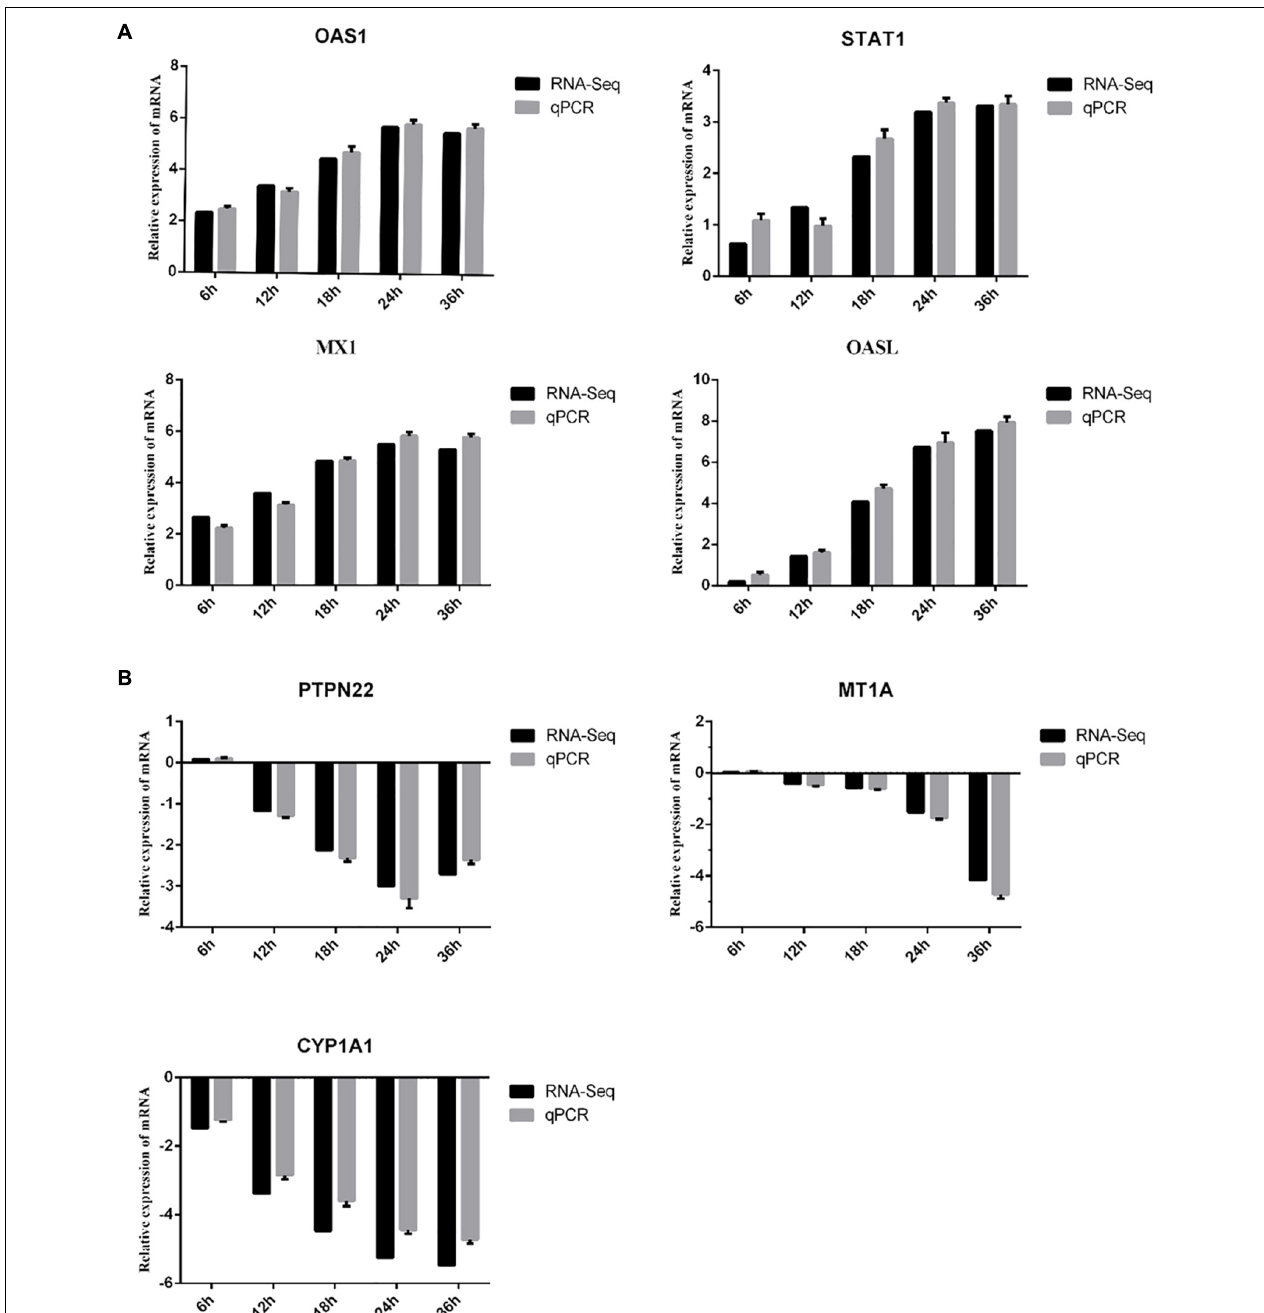
FIGURE 6 | Verification of DEGs by RT-qPCR. The x -axis indicates the time post-infection, and the y -axis represents the fold changes after SVA infection. (A) The up-regulated DEGs. (B) The down-regulated